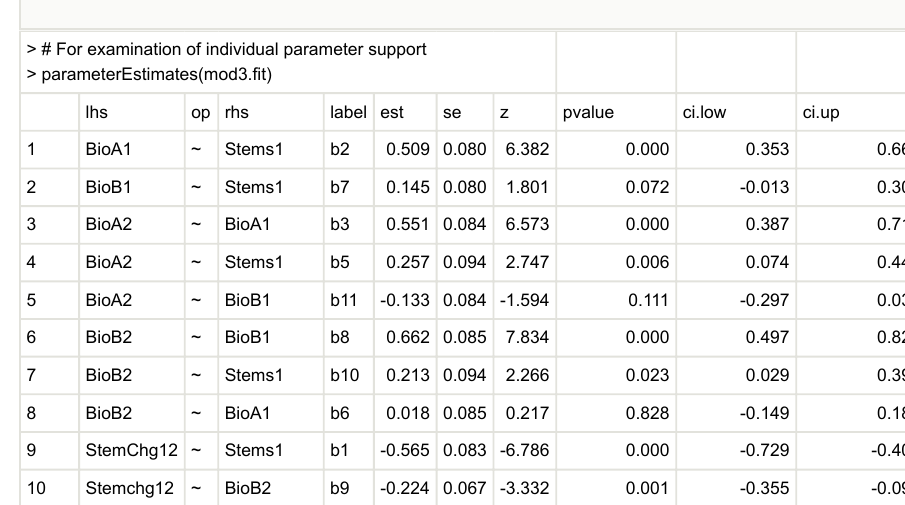
Table 9. Parameter-specific statistics for Model